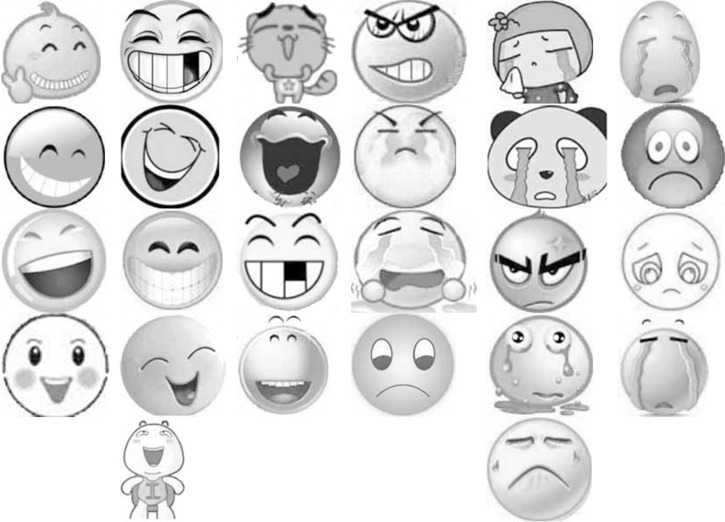
Positive and negative icon-pictures in Experiment 3.